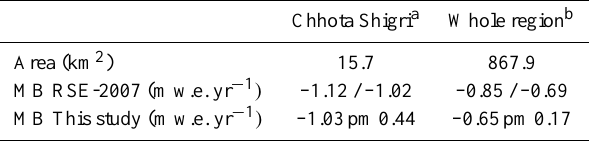
Table 3. Comparison of the 1999-2004 geodetic MB published pre- viously (Berthier et al., 2007) and the revised values using up-to- date corrections and error analysis (Gardelle et al., 2012a, b). In the 2007 publication, no error analysis was performed but two val- ues were provided corresponding to two density scenarios for the volume-to-mass conversion in the accumulation